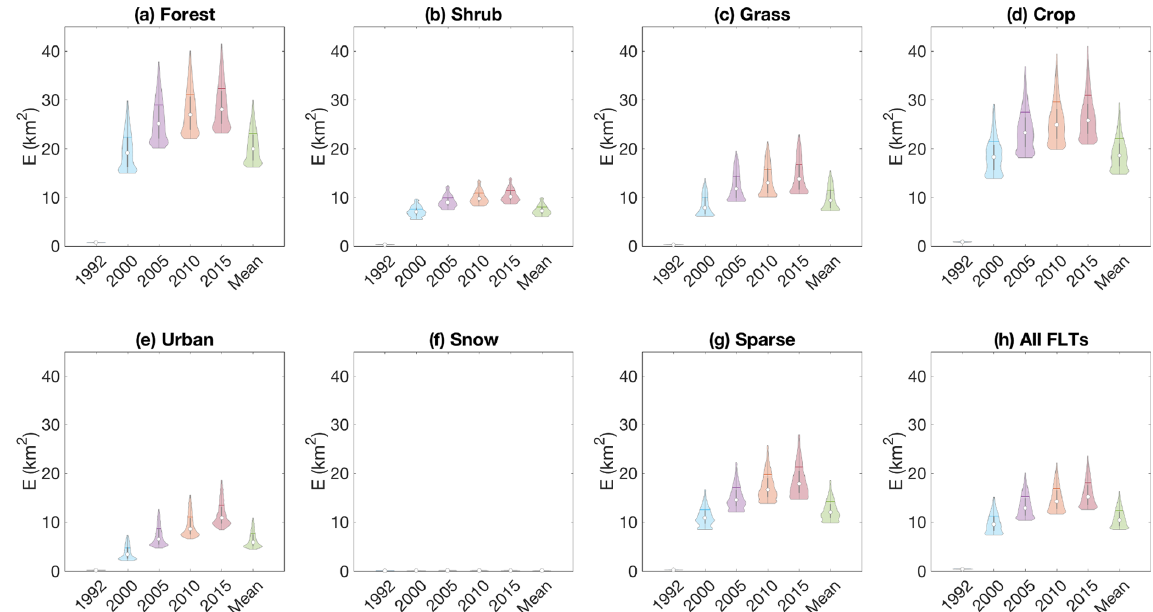
Figure 5. Possibility densities for the E values between downscaled and observational final land type areas for 1992, 2000, 2005, 2010, 2015, and the mean of the five time steps. The box plots and horizontal bar inside the violin plots indicate the interquartile ranges and the mean of the parameter values, respectively. Note that the E values for snow are close to 0 and thus not visible in the figure.